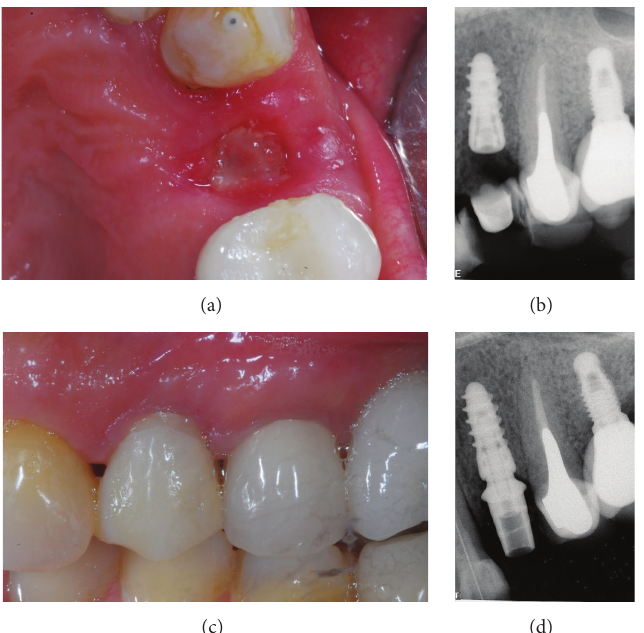
Figure 4: A single 3DP/AM titanium dental implant in a postextraction socket of the posterior maxilla: healing phases. (a) Ten days after surgery, sutures are removed. (b) Periapical rx 10 days after implant placement. (c) Three months later, a provisional restoration is placed. (d) Periapical rx at placement of the provisional restoration.